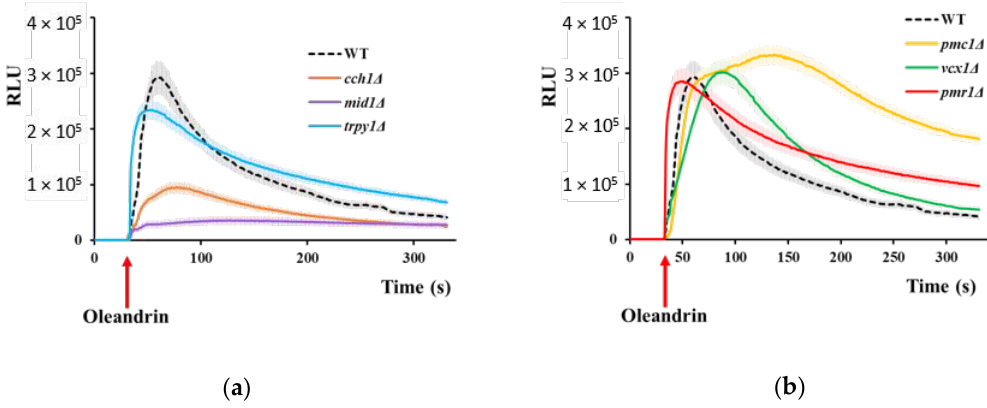
Figure 2. Increase in [Ca 2 + ] cyt under oleandrin exposure. Wild type cells or cells defective in calcium transport expressing reconstituted aequorin were pre-grown in SD-Ura and subjected to oleandrin stress (100 ng / mL) as described in Materials and Methods . [Ca 2 + ] cyt -dependent aequorin luminescence was recorded on samples of approximately 10 7 cells (OD 600 = 1). The arrow indicates the time when oleandrin was added. ( a ) Calcium-dependent luminescence of wild type, and of mutants with defects in Ca 2 + release to the cytosol cch1 ∆ , mid1 ∆ and trpy1 ∆ . ( b ) Calcium-dependent luminescence of type, and of mutants with defects in Ca 2 + removal from cytosol pmc1 ∆ , vcx1 ∆ and pmr1 ∆ . The traces represent the mean ± SEM from 3 independent transformants. SEM are illustrated as bars of a lighter nuance. RLU, relative luminescence